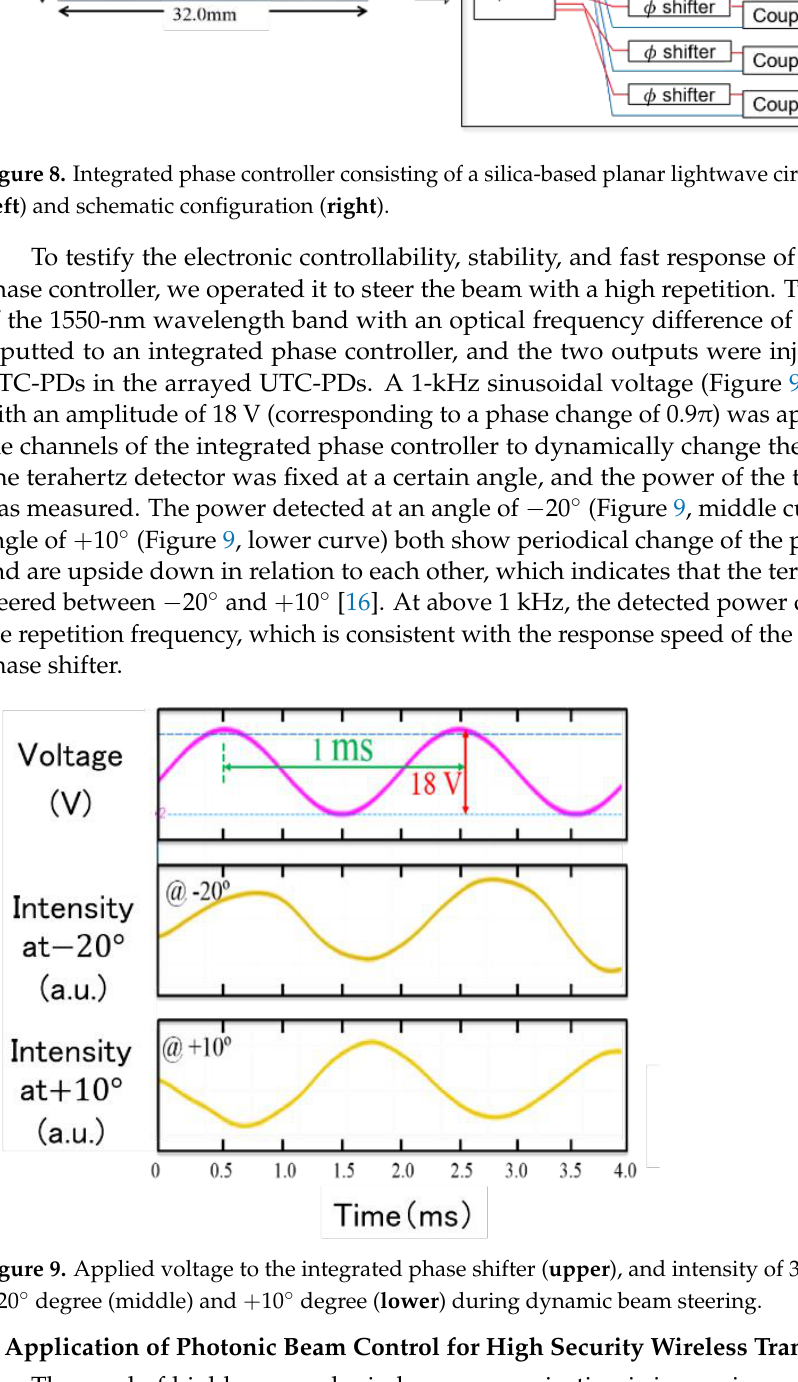
Figure 9. Applied voltage to the integrated phase shifter ( upper ), and intensity of 300-GHz wave at −20° degree (middle) and +10° degree ( lower ) during dynamic beam steering.